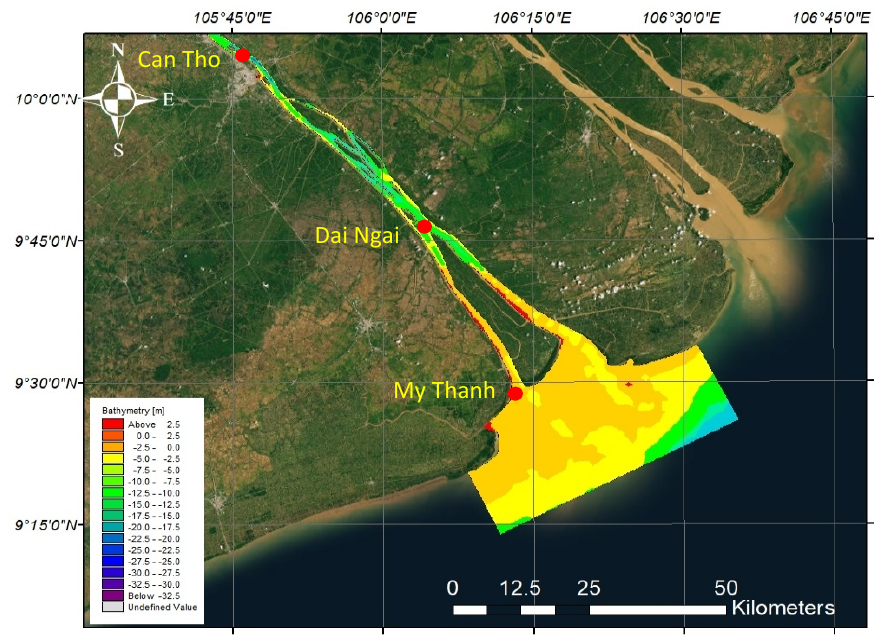
Figure 1. The study area for the whole Vietnamese Mekong Delta (VMD) (top panel) and 2D study domain (bottom panel).